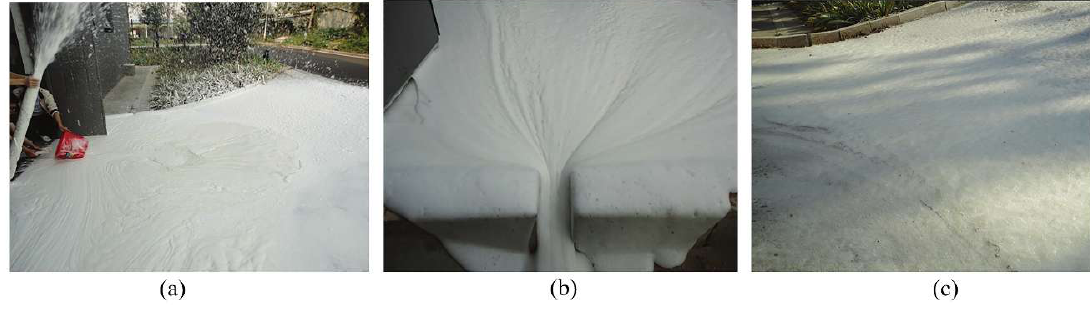
Figure 14. The foamed gel prepared in lab: ( a ) Foaming; ( b ) fluidity; ( c ) film forming ability [59].